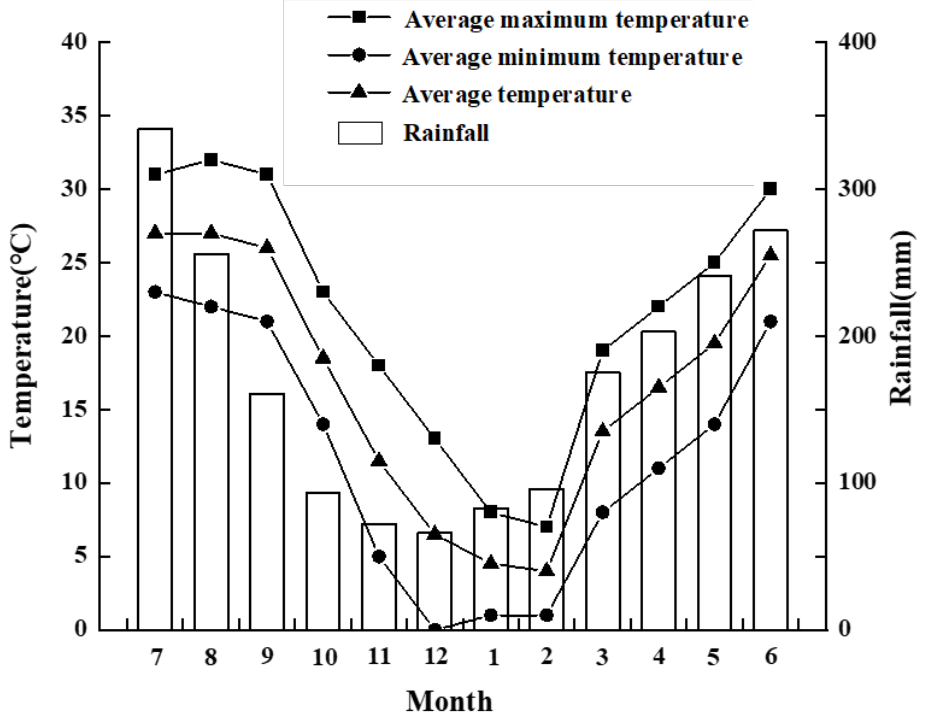
Figure 1. Monthly rainfall and maximum, minimum, and average temperatures at Tianhu Mountain County Nature Reserve.